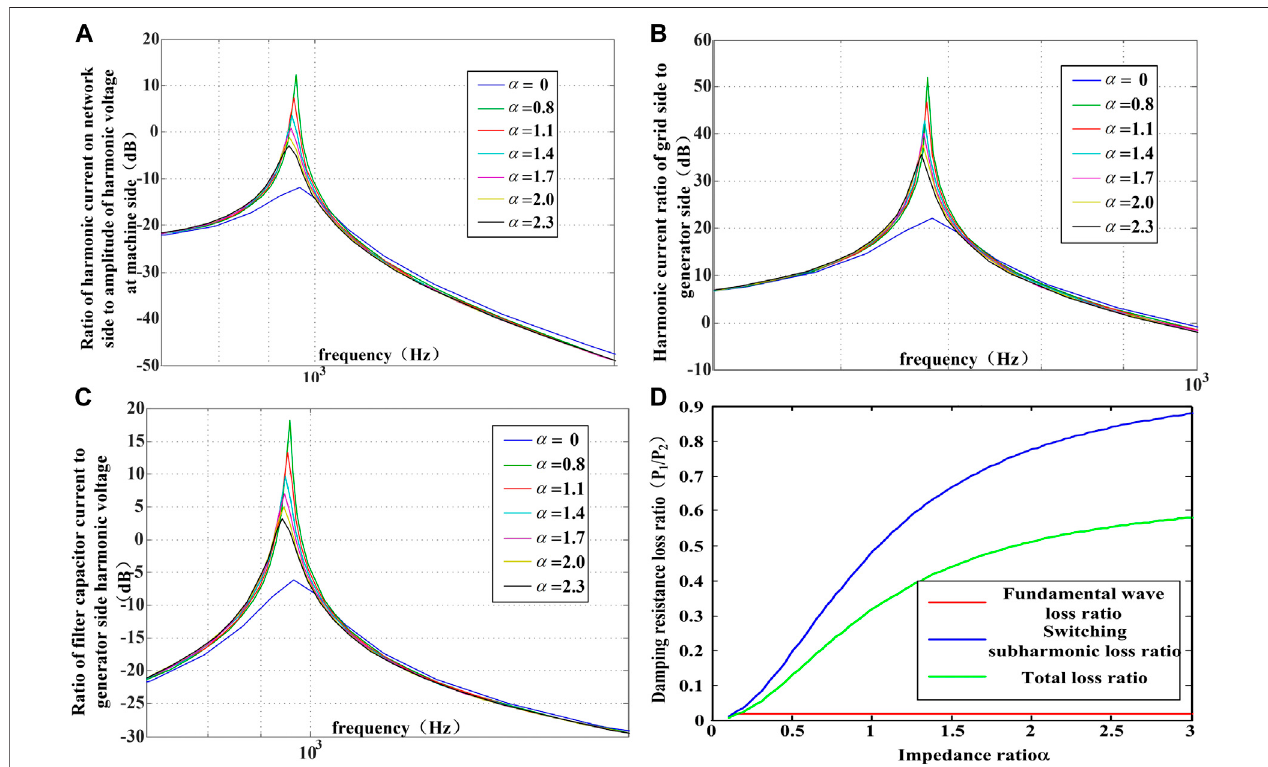
FIGURE 6 | Bode diagrams and damping resistance loss ratio of the LCL fi lter. (A) Ratio of grid-side harmonic current to machine-side amplitude of harmonic voltage. (B) Ratio of grid-side harmonic current to machine-side harmonic current. (C) Ratio of fi lter capacitor current to machine-side harmonic voltage. (D) Damping resistance loss ratio of LCL fi lter with damping inductance and without damping inductance.